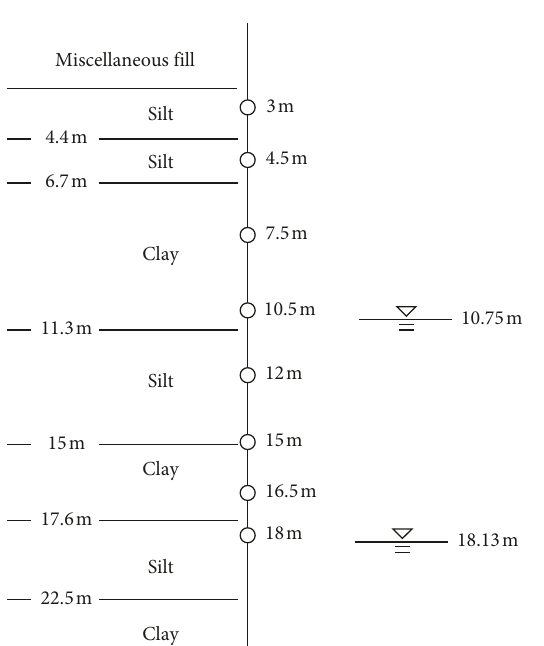
Figure 2: Stratigraphy of the test site.